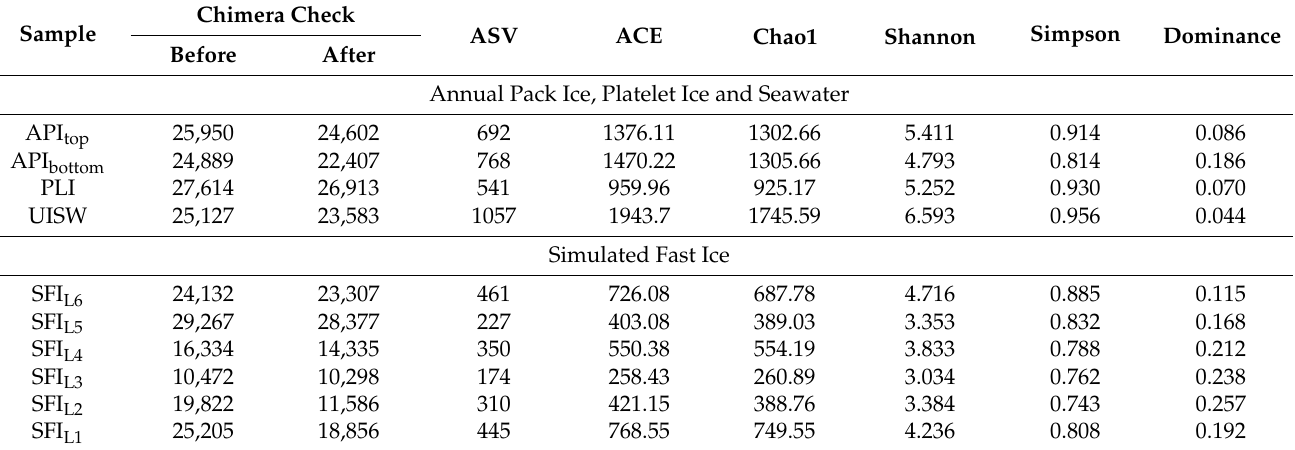
Table 2. Prokaryotic richness and diversity estimates, based on 97% ASV clusters of Antarctic sea-ice- associated microbial communities. The diversity indexes: abundance-based coverage estimator of species richness (ACE), abundance-based estimator of species richness (Chao1), estimators of species richness (Shannon) and species evenness